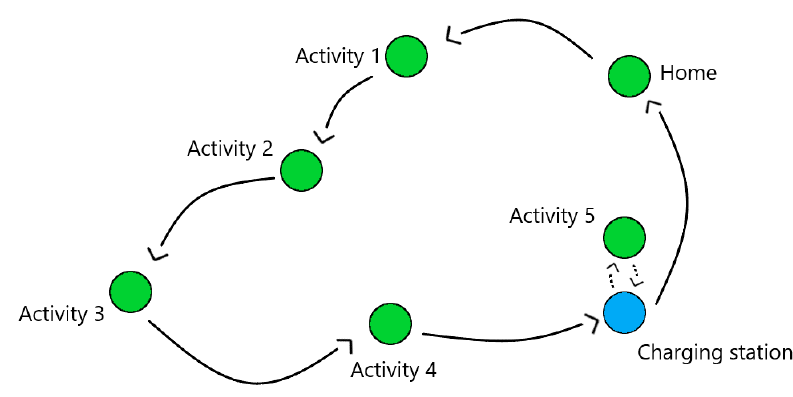
Figure 2. The en passant charging scenario of the DACO-EV problem.